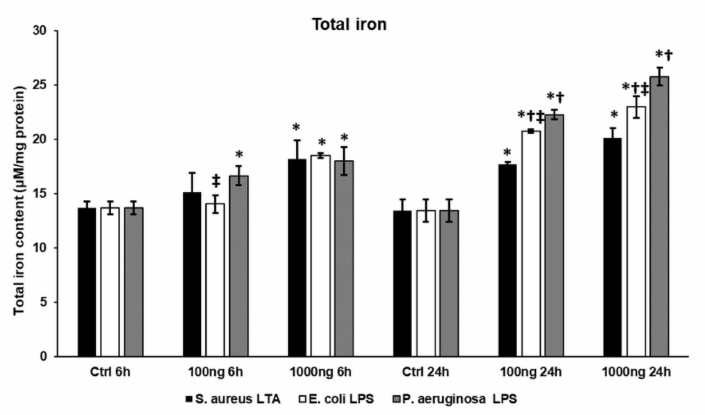
Figure 6. Determinations of total iron content of THP-1 cells treated with S. aureus lipoteichoic acid (LTA), E. coli lipopolysaccharide (LPS) and P. aeruginosa LPS. Iron content of THP-1 cells was determined using a colorimetric ferrozine-based assay and was expressed as µ M/mg protein. The columns represent mean values and error bars indicate standard deviation (SD) of three independent determinations ( n = 3). The measurements were carried out in quadruplicate in each independent experiment. An asterisk * marks p < 0.05 compared to the controls. A cross † indicates p < 0.05 compared to S. aureus LTA treatment and a double cross ‡ shows p < 0.05 compared to P. aeruginosa LPS